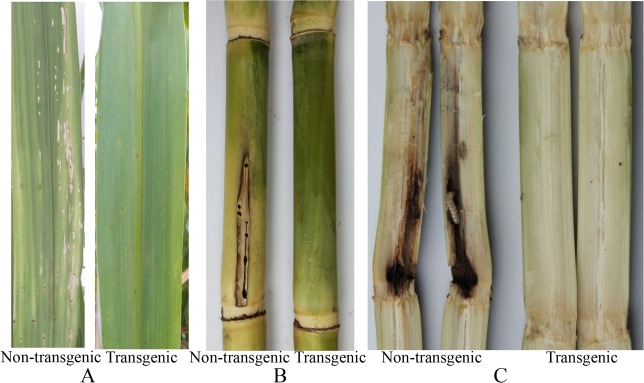
Typical symptoms caused by natural stem borer infestation in the field.A: Leaf symptoms; B: Stem symptoms (aspect); C: Stem symptoms (inside stalk).